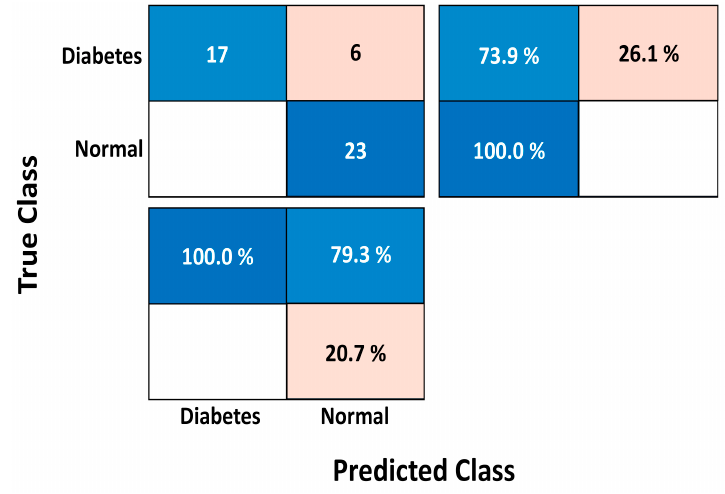
Figure 12. Confusion matrix for weighted KNN with testing accuracy: 86.96%.